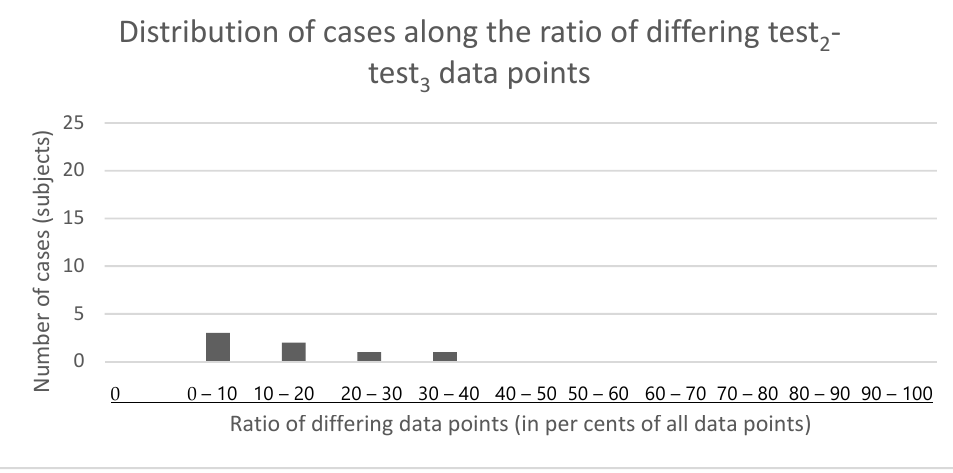
Figure 2. Histogram of the 7 subjects with nonidentical data series when comparing their test 2 and test 3 data, along the ratio of differing data points. (Data of 5 subjects with identical test 2 –test 3 datasets are not included).